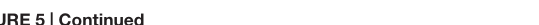
FIGURE 5 | Continued Expression of apoptosis related proteins (E,F) and pathway related proteins (G,H) detected by Western blotting treated with baclofen and CoCl 2 for 24 h as presented. α -tubulin served as a loading control. The level of protein in each group was expressed as the value relative to the control. The data represent the mean ± SD of three independent experiments. ( ∗ p < 0.05, vs.